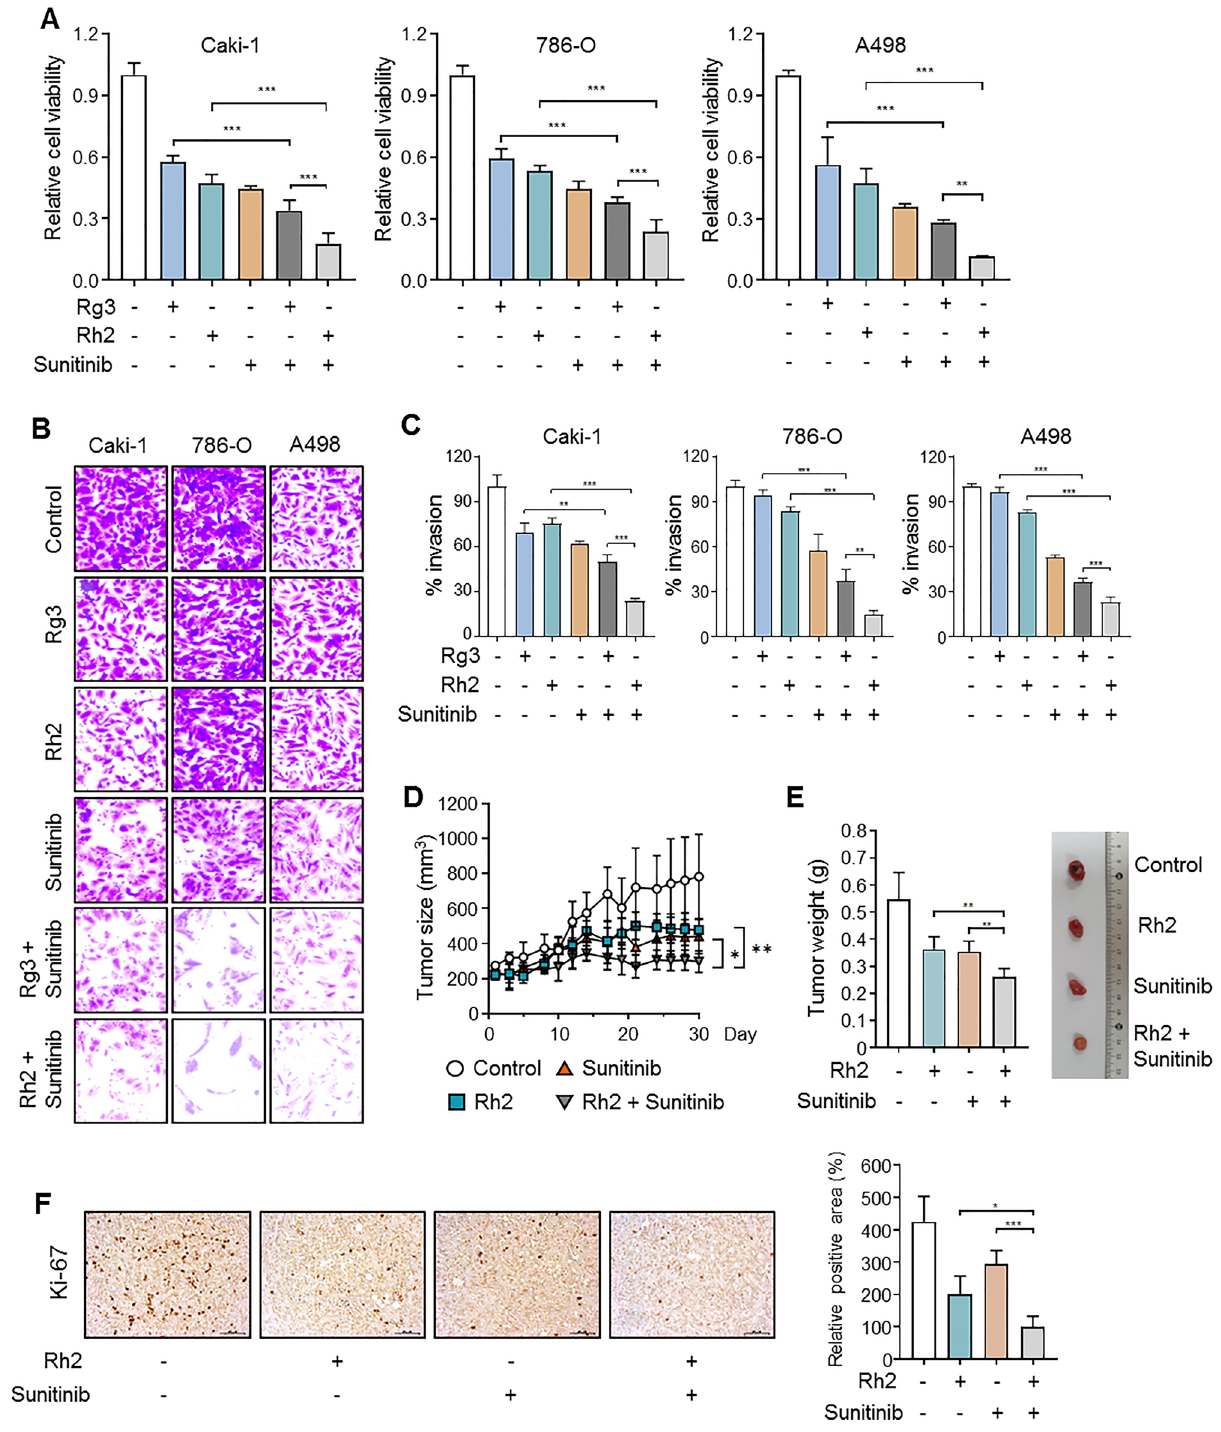
Figure 1. Ginsenoside enhances the anti-proliferative effects of sunitinib in ccRCC cell lines and the xenograft model. ( A ) Cell viability was measured after 24 h of drug co-treatment with ginsenoside and sunitinib. Caki-1, 786-O, and A498 cells were treated with Rh2 (10 μM), Rg3 (10 μM), and sunitinib (10 μM) (**p < 0.01, ***p < 0.001). Perform at least three biological repeats (n = 3). ( B ) The Matrigel invasion assay showed that anti-invasiveness significantly decreased in ccRCC cell lines after co-treatment with ginsenoside and sunitinib. The representative images were obtained after 24 h of drug treatment. (n = 3). ( C ) Numbers of invading cells in each group (**p < 0.01, ***p < 0.001). (n = 3). ( D , E ) A498 cells were injected subcutaneously into balb/c nude mice (n = 5). We evaluated tumor volumes and sizes in four treatment groups: DMSO, Rh2 (10 mg/kg), sunitinib (10 mg/kg), and Rh2 + sunitinib. Mice received intraperitoneal injections of ginsenoside three times per week and sunitinib was given by oral administration every day. All groups were evaluated three times per week. The tumor weights were evaluated after 4 weeks of treatment (*p < 0.05, **p < 0.01). ( F ) Immunohistochemistry (IHC) staining for Ki-67 in A498 xenograft treated with Rh2/sunitinib. We quantified the Ki-67 positive areas identified in five mice tissues per group (*p < 0.05, ***p < 0.001). (200 ×